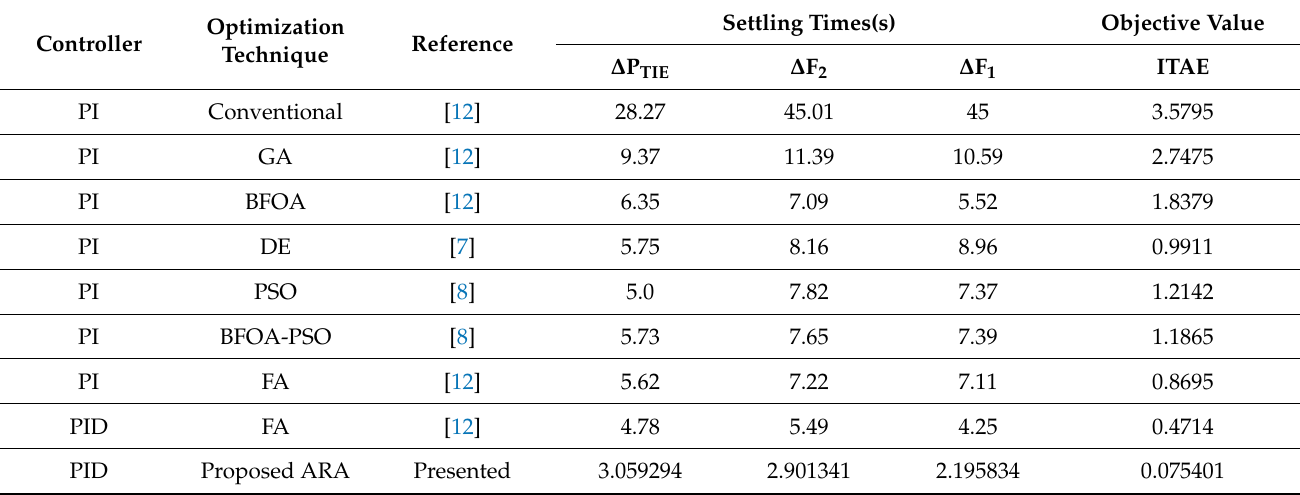
Table 2. Comparative performance of various algorithms in terms of ITAE and settling time.